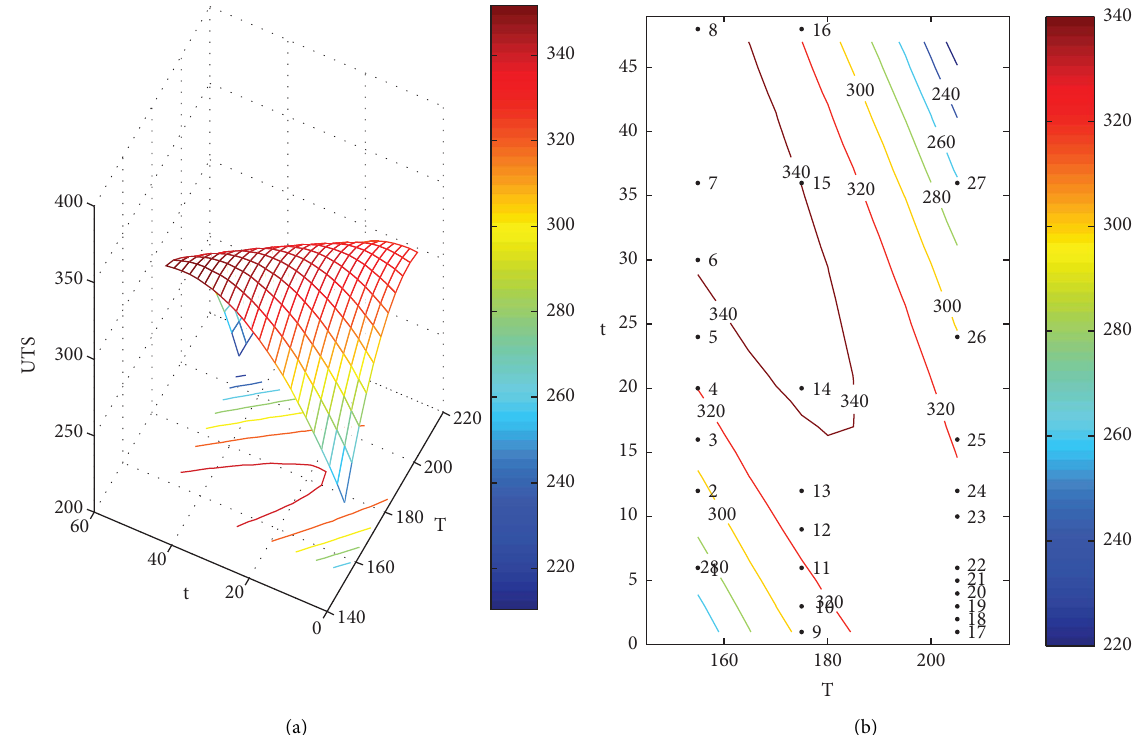
Figure 2: 3D surface graph of the regression model (a) and quality map (b) for UTS of cast aluminum alloy A357 according to artifcial aging heat treatment condition.